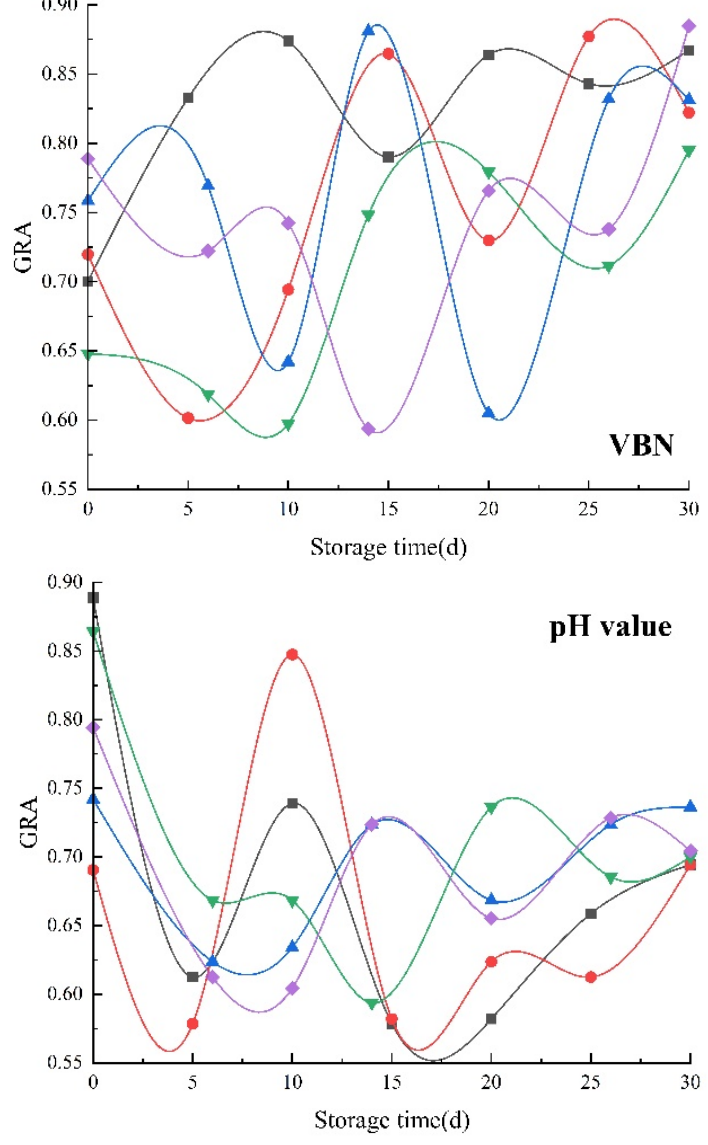
Figure 5. The trend of the GRA between the freshness indexes of fishmeal and mold count during storage under different temperatures.